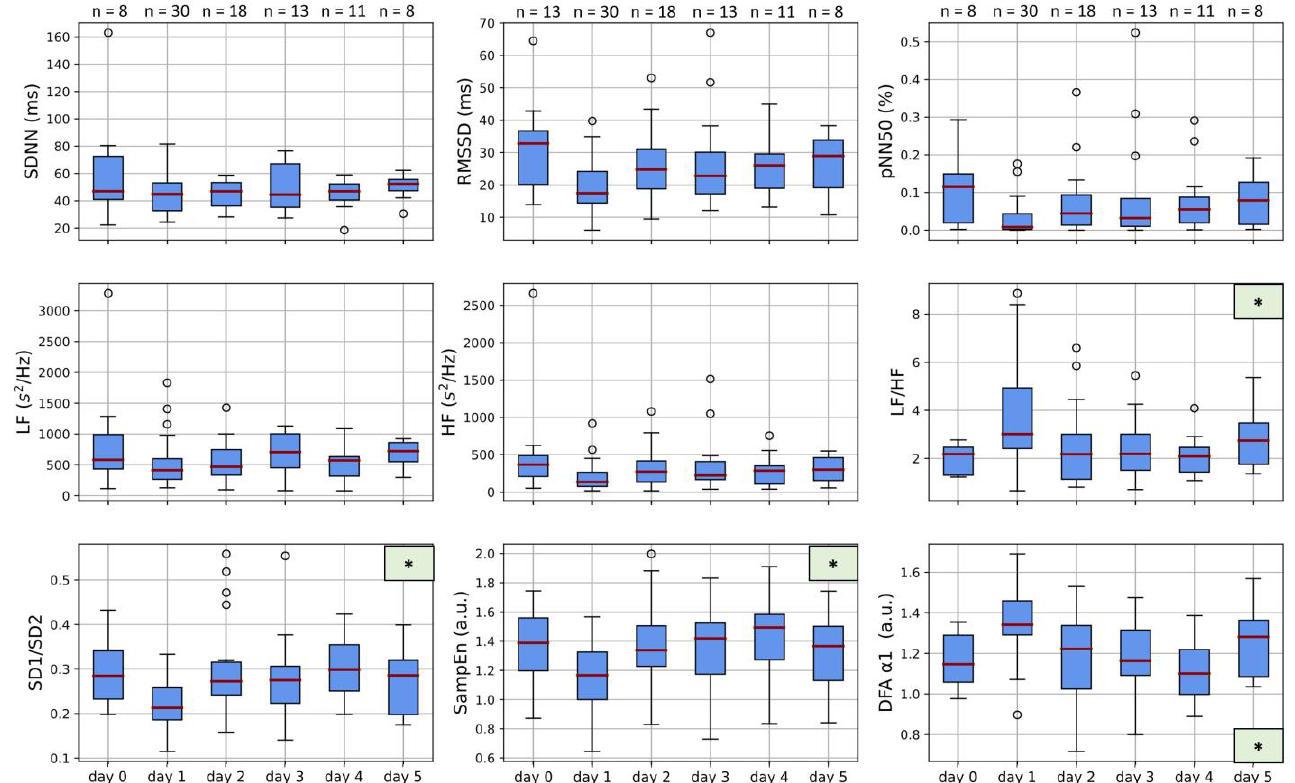
Figure A2. Boxplots of maternal HRV on days 0 to 5 , excluding all participants who were also administered nifedipine. Boxplots represent the median, interquartile range, and interdecile range of the values. Day 0 represents measurements taken before the first injection of betamethasone, while day 1 represents 24 h after the first injection, day 2 represents 48 h after the first injection, etc. * represents a statistically significant finding with p < 0.05. The number of measurements incorporated into each day is displayed at the top of the graph.